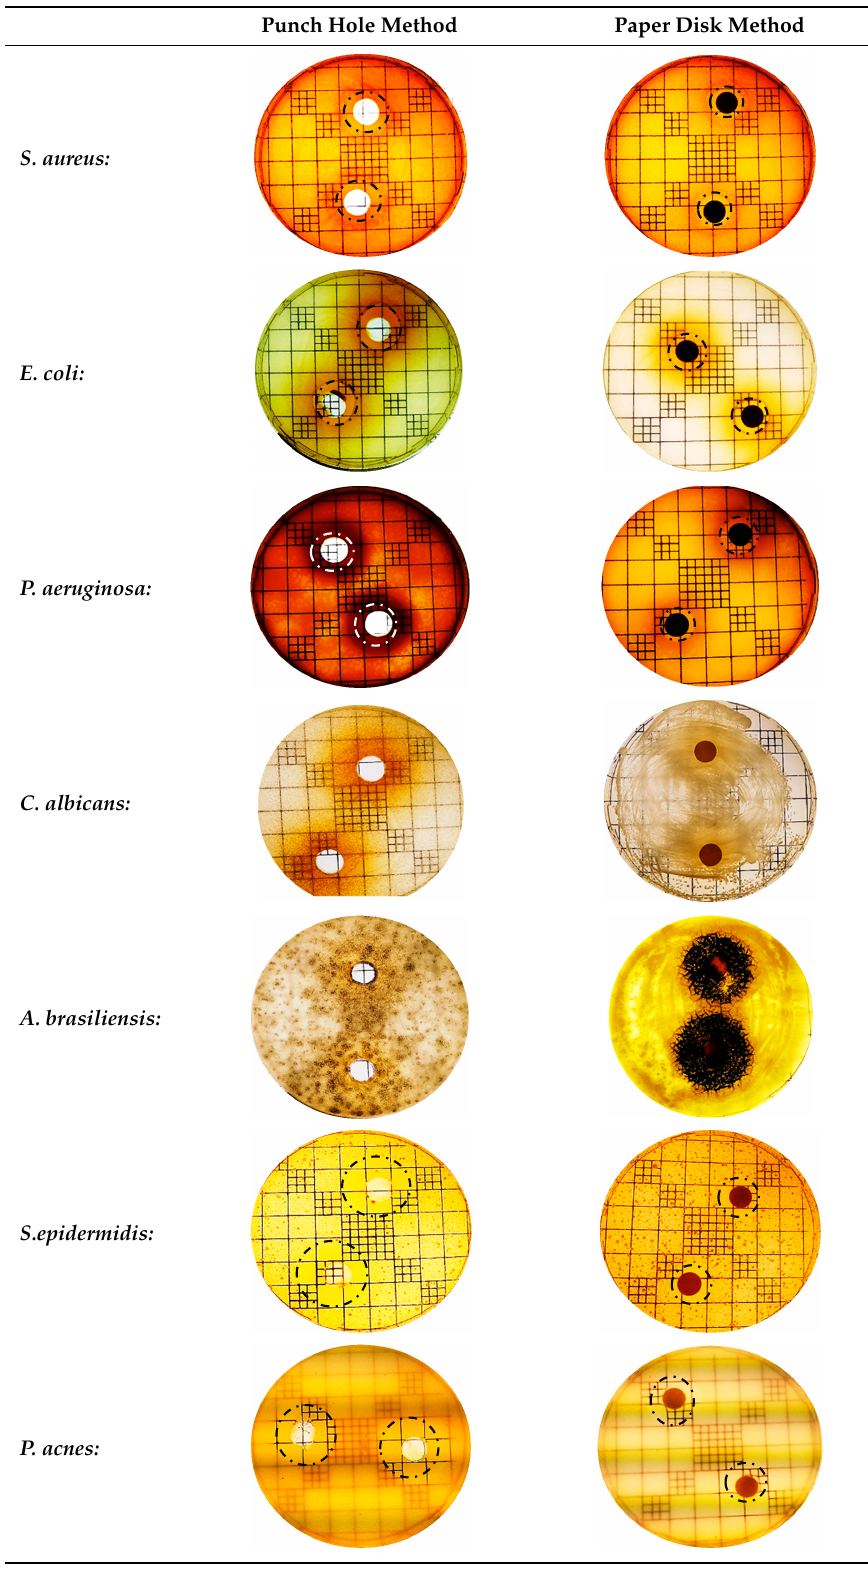
Table 4. Studies on the antimicrobial e ff ects of the OMWW extract on various microorganisms by detection of the inhibition zone, by the punch hole and the paper disk method. The dashed line Table 4. Studies on the antimicrobial effects of the OMWW extract on various microorganisms by Table 4. Studies on the antimicrobial effects of the OMWW extract on various microorganisms by Table 4. Studies on the antimicrobial effects of the OMWW extract on various microorganisms by Table 4. Studies on the antimicrobial effects of the OMWW extract on various microorganisms by Table 4. Studies on the antimicrobial effects of the OMWW extract on various microorganisms by Table 4. Studies on the antimicrobial effects of the OMWW extract on various microorganisms by detection of the inhibition zone, by the punch hole and the paper disk method. The dashed line detection of the inhibition zone, by the punch hole and the paper disk method. The dashed line detection of the inhibition zone, by the punch hole and the paper disk method. The dashed line detection of the inhibition zone, by the punch hole and the paper disk method. The dashed line detection of the inhibition zone, by the punch hole and the paper disk method. The dashed line detection of the inhibition zone, by the punch hole and the paper disk method. The dashed line identifies the inhibition zone. identifies the inhibition identifies the inhibition zone. identifies the inhibition zone. identifies the inhibition zone. identifies the inhibition zone. identifies the inhibition zone.